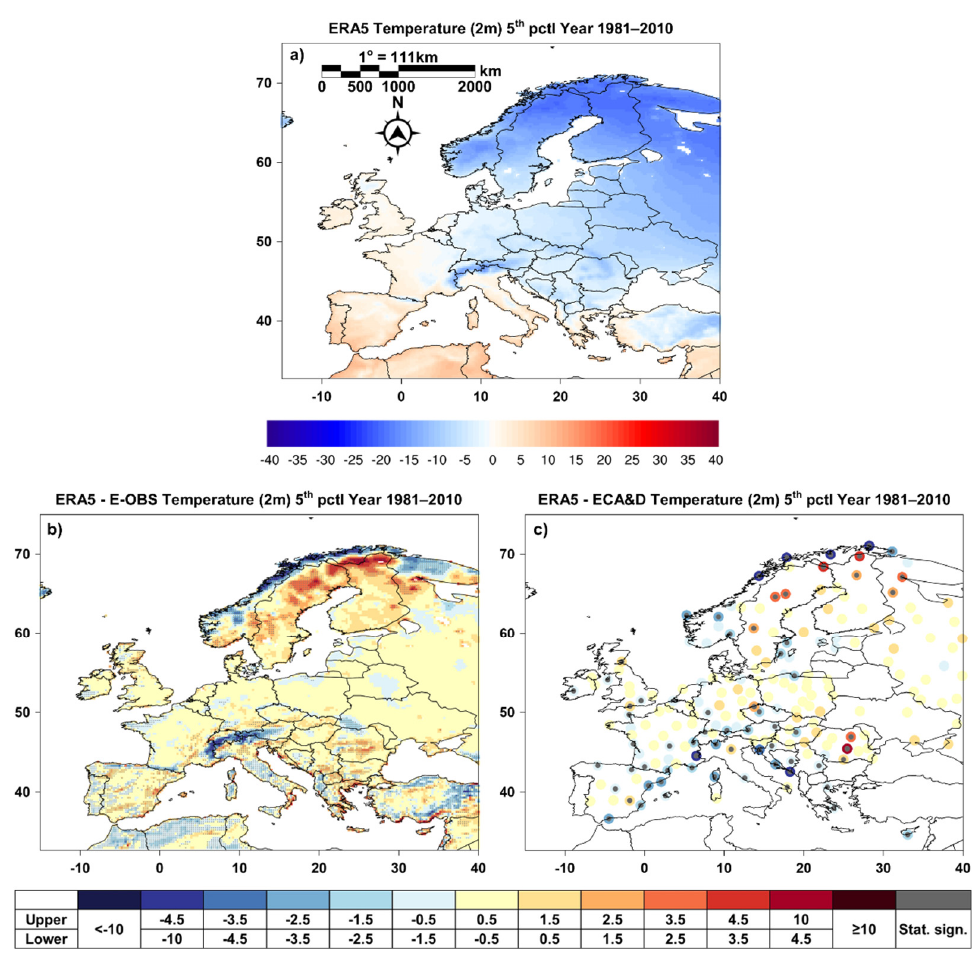
Figure 5. Extreme low mean temperature (°C) (fifth percentile) for ( a ) ERA5, and the differences between ( b ) ERA5 and E-OBS, and ( c ) ERA5 and ECA&D stations.